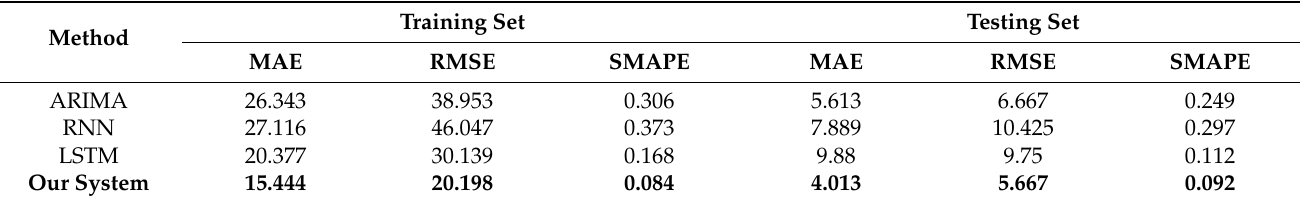
Table 7. Comparison of index values of each model on Eagle Harbor dataset.